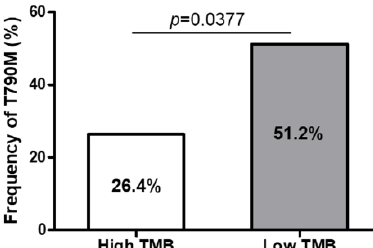
Figure 3. Frequency of secondary T790M mutation after tyrosine kinase inhibitor failure according to different TMB level. The rate of T790M mutation is significantly lower in the high TMB group compared with the low TMB group ( p = 0.0377).